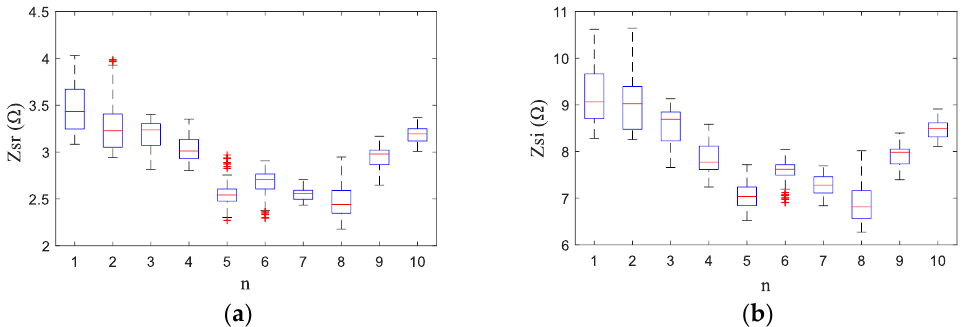
Figure 5. Results of method 2 in simulation I. ( a ) The result of the real part; ( b ) The result of the imaginary part.